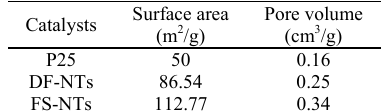
Table 2. Surface area and total pore volume corresponding to the different